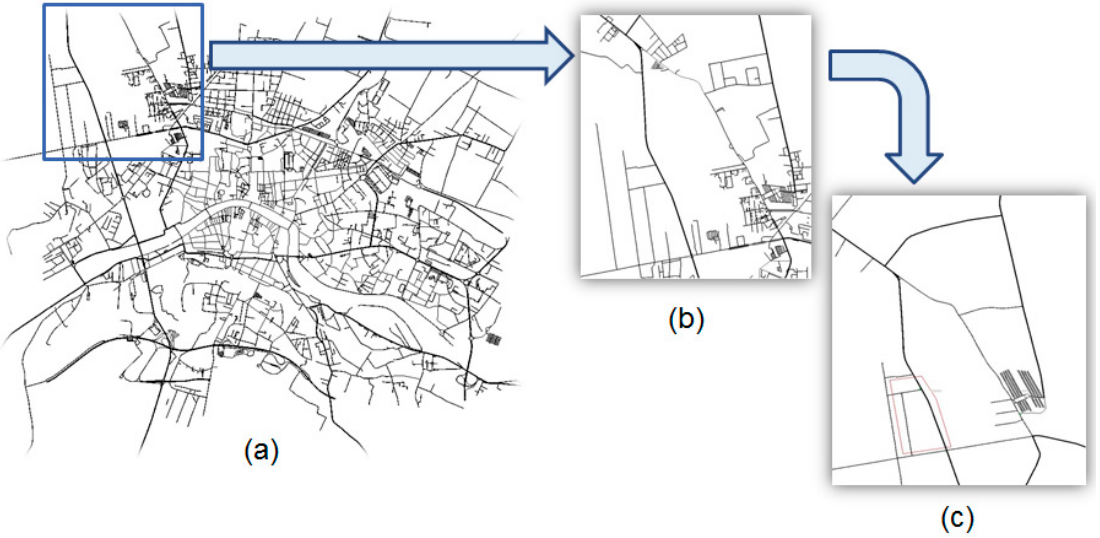
Figure 4. Map in SUMO used for the simulation: ( a ) Pisa city centre. In blue the selected area for the urban use cases simulation; ( b ) Zoom over the selected area, with a 350 slots parking facility; ( c ) Simplified model for the simulations, with the main road connections and the parking facility.